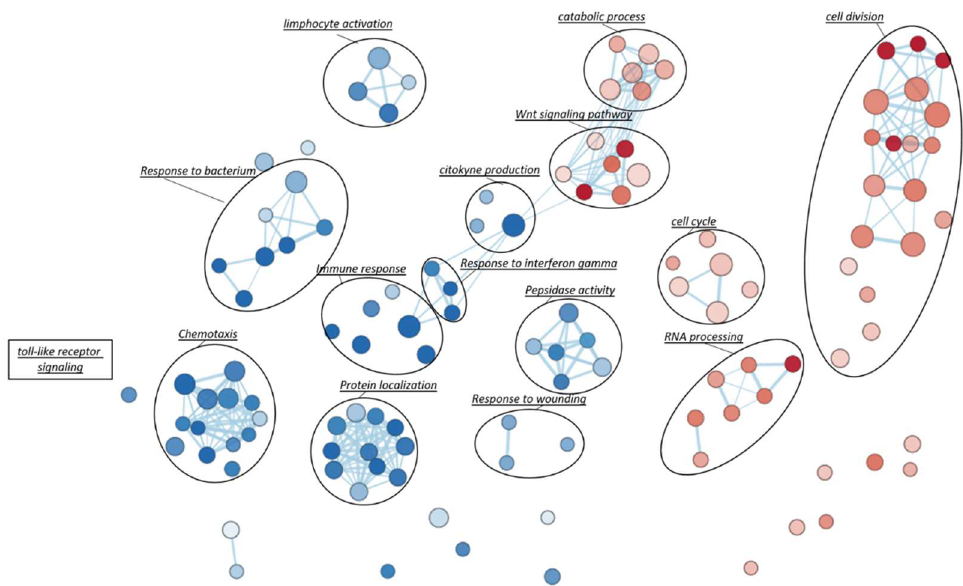
Figure 4. Gene-Set Enrichment Analysis (GSEA). To visually interpreting biological data from GSEA analysis, a network of the most significant Gene Ontology biological processes (GO-BP) terms ( p < 0.05) was drawn. Blue and red nodes represent pathways mainly associated with CAD and CAD-DM conditions, respectively. The node gradient color is proportional to node significance, from lower (light node; p = 0.05) to higher (dark node; p << 0.0001); node size is proportional to the gene-set size. Edge thickness is proportional to the similarity between two gene-sets.